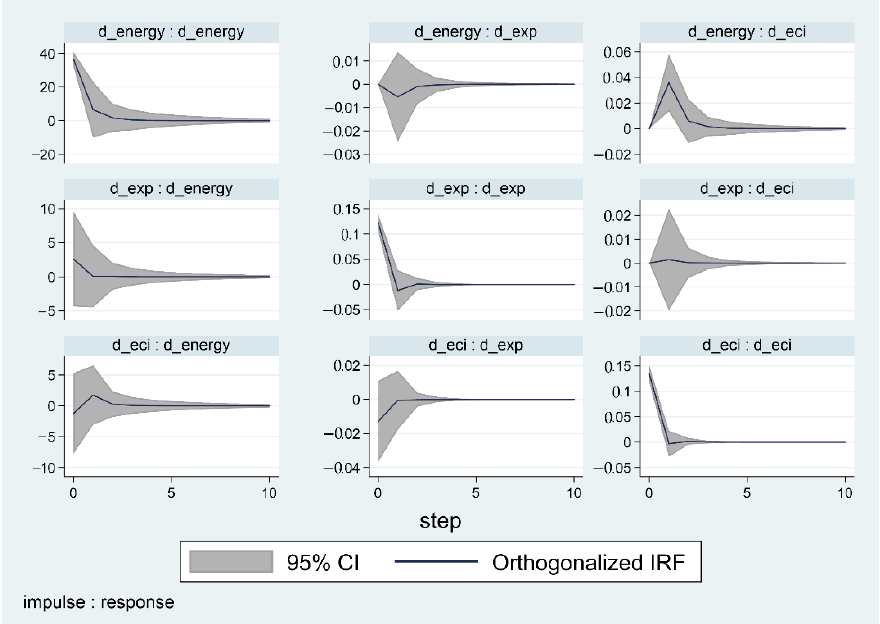
Figure 2. Impulse-response function.